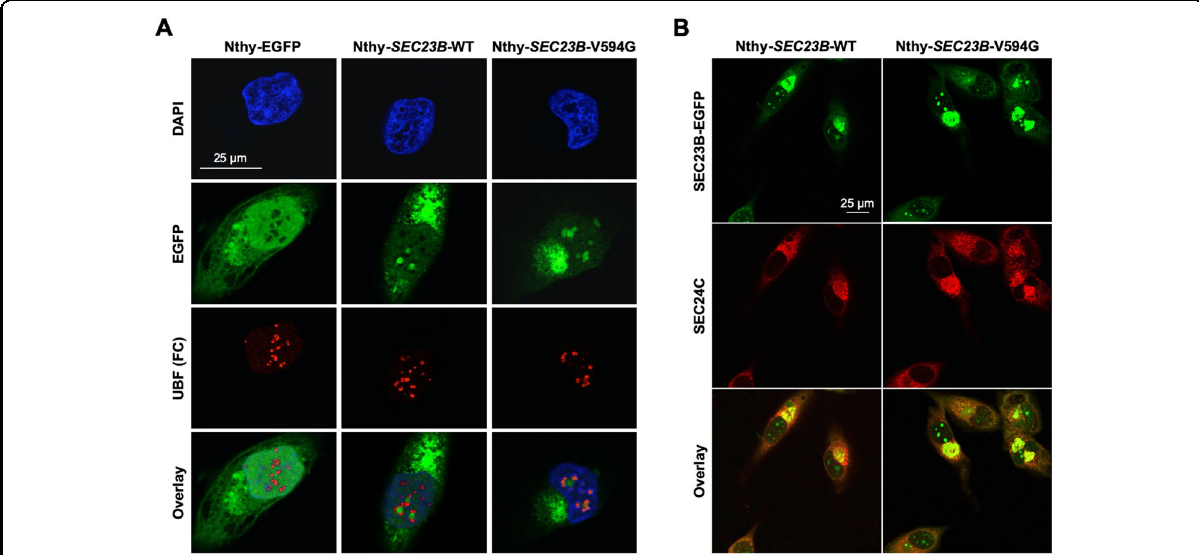
Fig. 3 Proteasome inhibition causes COPII-independent nucleolar localization of wild-type SEC23B. A Immuno fl uorescence staining of stably transduced Nthy-ori 3-1 thyroid cells with a nucleolar protein marker. FC fi brillar centre of the nucleolus. Scale bars, 25 µm. B Immuno fl uorescence staining of Nthy- SEC23B -WT and Nthy- SEC23B -V594G cells with anti-SEC24C antibody and DAPI, followed by imaging with confocal microscopy. Scale bars, 25